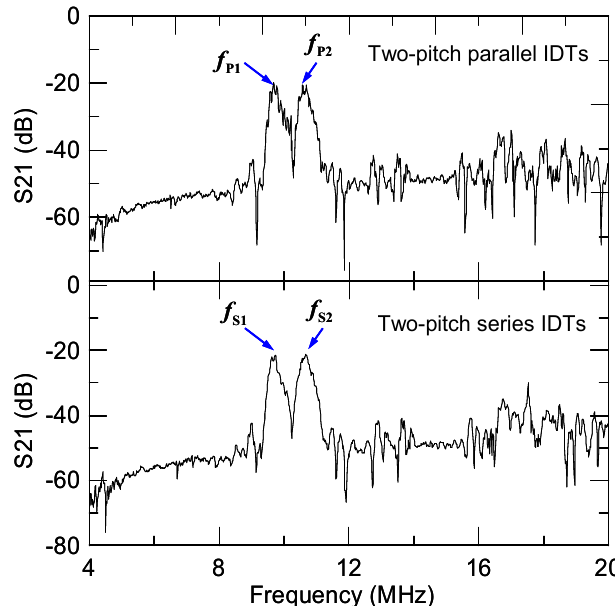
Figure 8. Measured frequency-domain responses (Scattering parameter S 21 using a network analyzer) of the two-pitch parallel and series IDTs fabricated on the LiNbO 3 wafer. Two frequency peaks are observed in each design of parallel or series IDTs. f P 1 = 9.68 and f P 2 = 10.56 MHz; f S 1 = 9.73 and f S 2 = 10.65 MHz.